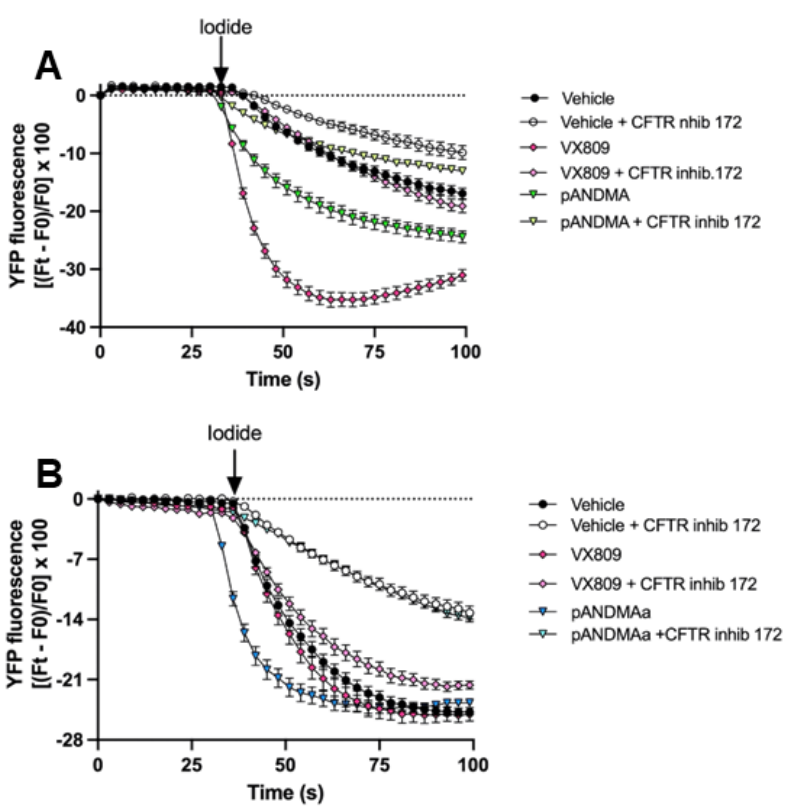
Figure 5. Representative time courses. Cells were treated for 48 h with vehicle or VX809 or 4-PhDMA ( A ) or pANDMAa ( pANDMA mesylate ) ( B ). CFTR activity was measured as described in Figure 3. The arrow indicates the addition of iodide.